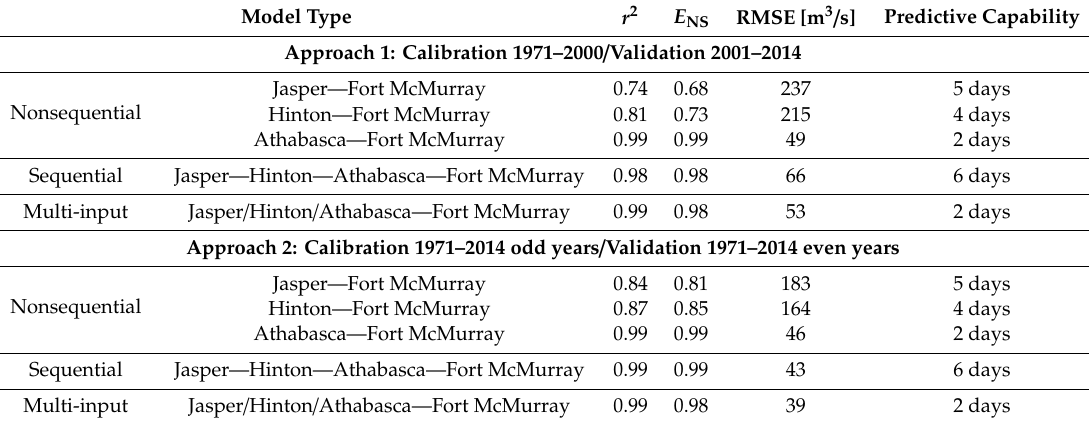
Table 4. Summary of the results to show the models’ performance in terms of coefficient of